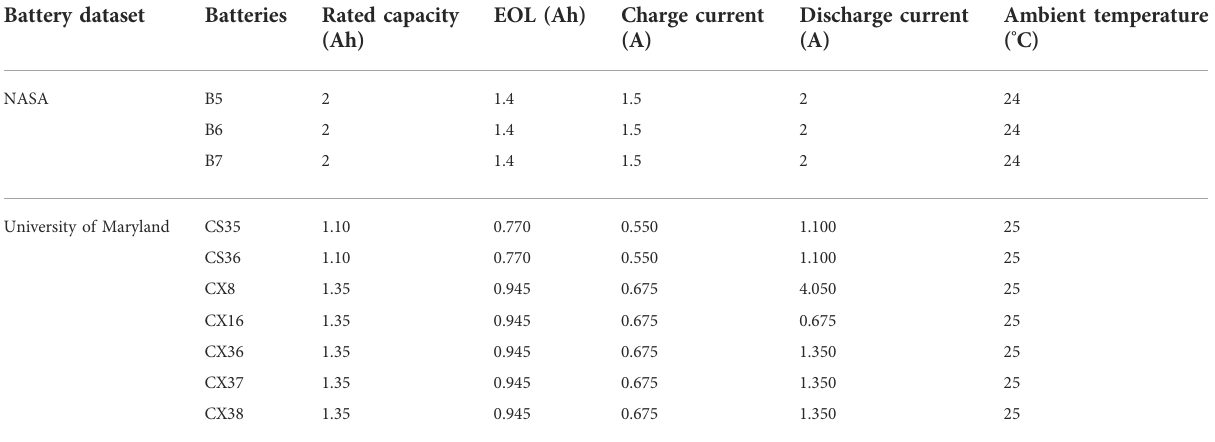
TABLE 1 Detailed parameters of all